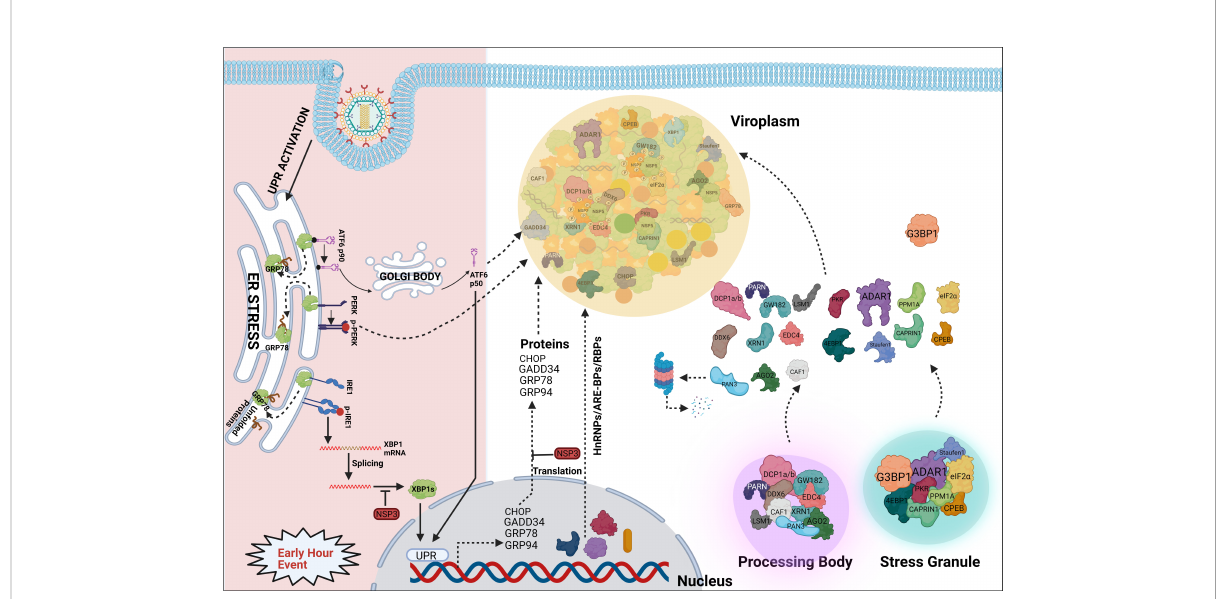
FIGURE 4 Sequestration of different host components into viroplasmic condensates. RV dismantles P bodies and SGs during infection. Many of the SG (ADAR1, eIF2 a , Caprin1, PKR, Staufen1, CPEB, 4EBP) and P body (DDX6, Lsm1, Caf1, PARN, XRN1, DCP1a, DCP1b) components relocate to viroplasms at least transiently or partially and interact with viroplasmic proteins. Additionally, many hnRNPs and ARE-BPs are re-located from the nucleus to the cytosol, get sequestered within viroplasms, and interact with NSP2 and NSP5 within RV infected cells. Many relocated RBPs are also absorbed by the viral transcripts. Accumulation of misfolded proteins in the ER leads to uncoupling of GRP78 from UPR sensors, resulting in activation of the three branches of UPR-the ATF6 pathway, the PERK-dependent pathway, and the IRE1-based signalling. During early hours of infection, RV activates the ATF6 and IRE1 branches of the UPR. Following dissociation from GRP78, the transcriptionally inactive fragment of ATF6 (ATF6p90) is translocated to the Golgi apparatus where it is cleaved into the transcriptionally active fragment (ATF6p50) which is further transported to the nucleus to trans-activate UPR elements (CHOP, GADD34, GRP78 and GRP94). Despite initial activation of the ATF6 branch of UPR, RV inhibits transcription of UPR elements by sequestering the ATF6p50 fragment into viroplasms. Moreover, activation of the IRE1 pathway includes dimerized and autophosphorylated IRE1 (p-IRE1) to trigger splicing of xbp1 mRNA (xbp1u) to generate a spliced variant (xbp1s). However, further translation of the xbp1s is prevented as a result of the host translational inhibition mediated by RV-NSP3. Release of PERK from GRP78 leads to homo-dimerization and phosphorylation of PERK; however, RV sequesters p-PERK in the viroplasms inhibiting further activation. Additionally, RV blocks the potential antiviral effects of UPR by inhibiting the translation of ER stress responsive genes and by re-locating many UPR effector proteins (CHOP, GADD34, GRP78, GRP94) near/within viroplasms at the late hours of